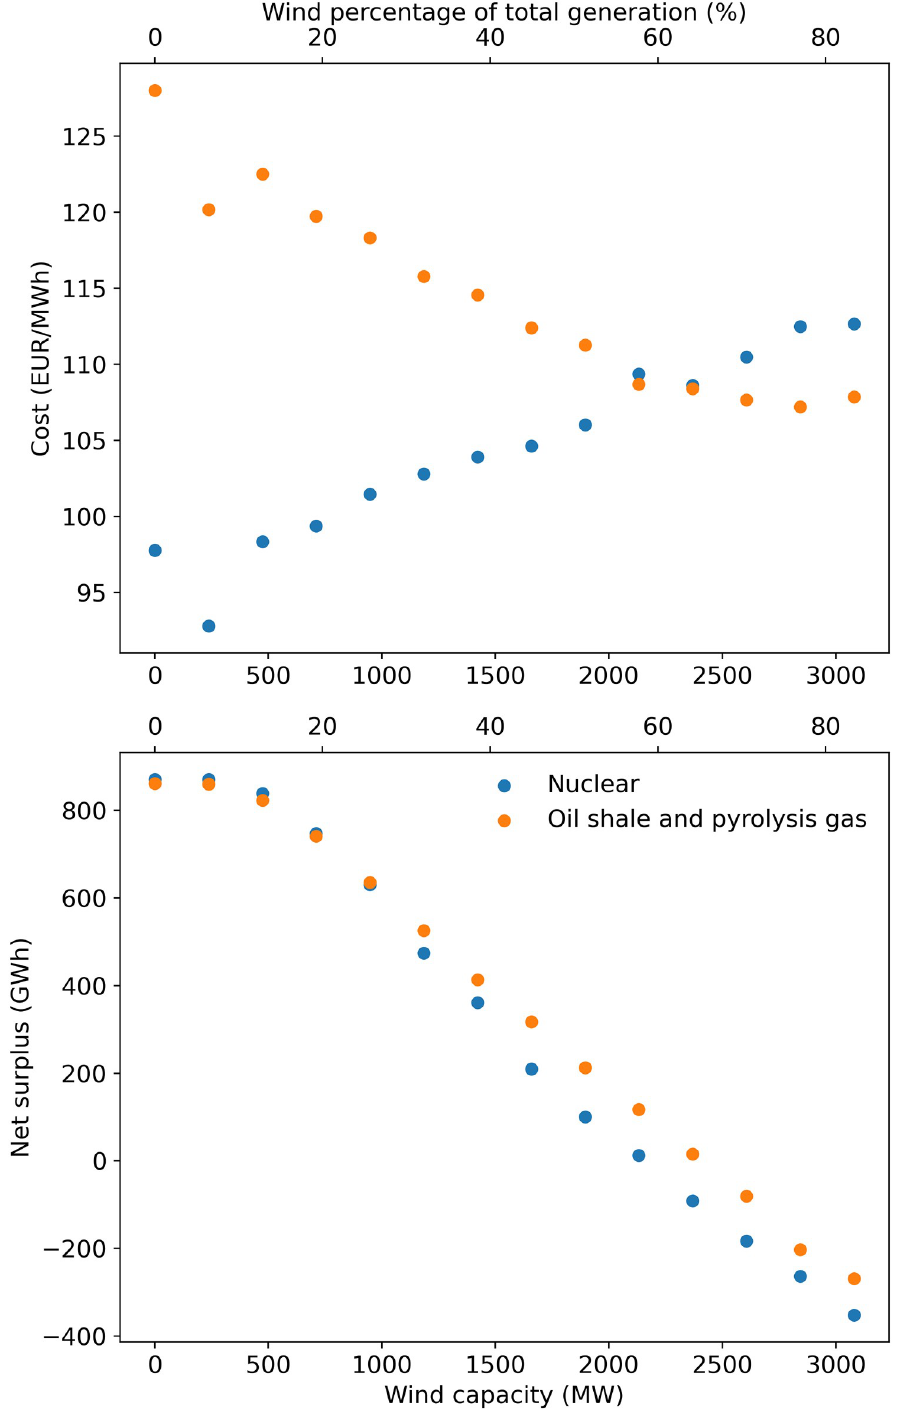
Fig 7. How increasing the wind turbine capacity would affect the levelized cost of electricity and surplus for the electricity system as a whole.